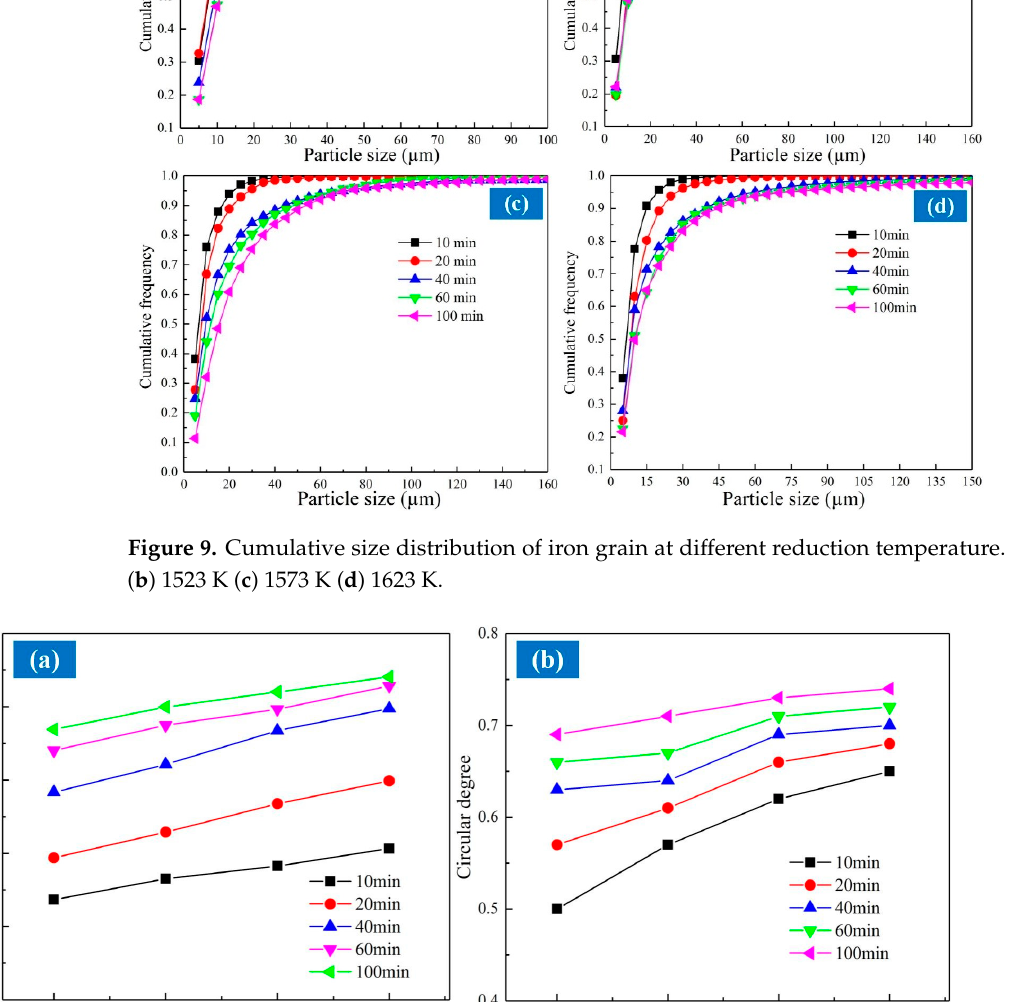
Figure 9. Cumulative size distribution of iron grain at different reduction temperature. ( a )1473 K ( b ) 1523 K ( c ) 1573 K ( d ) 1623 K.